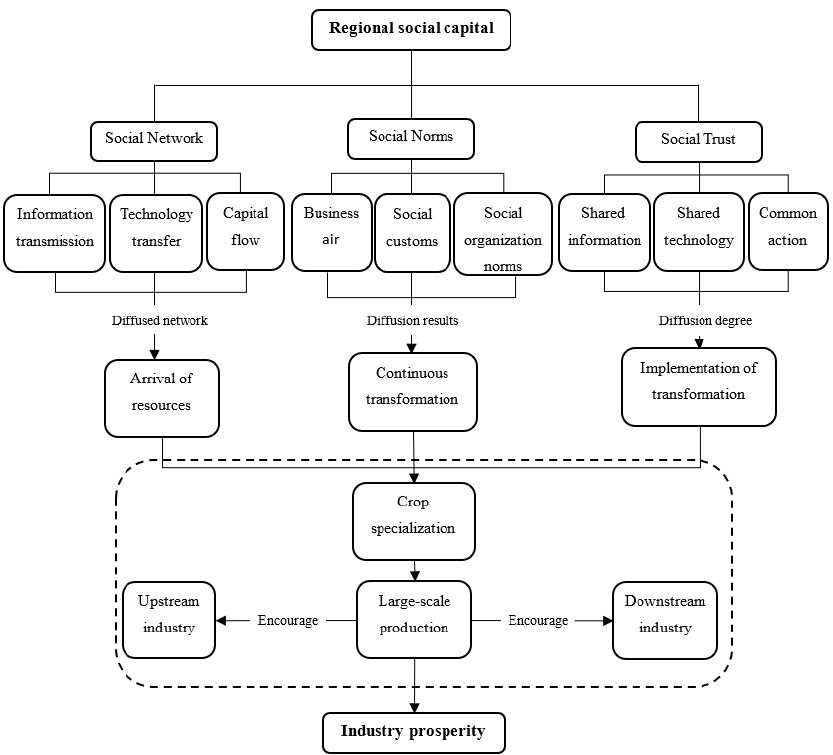
Figure 1. Logical relationships among village social capital, crop specialization and industrial re- vitalization. Figure 1. Logicalrelationshipsamongvillagesocialcapital,